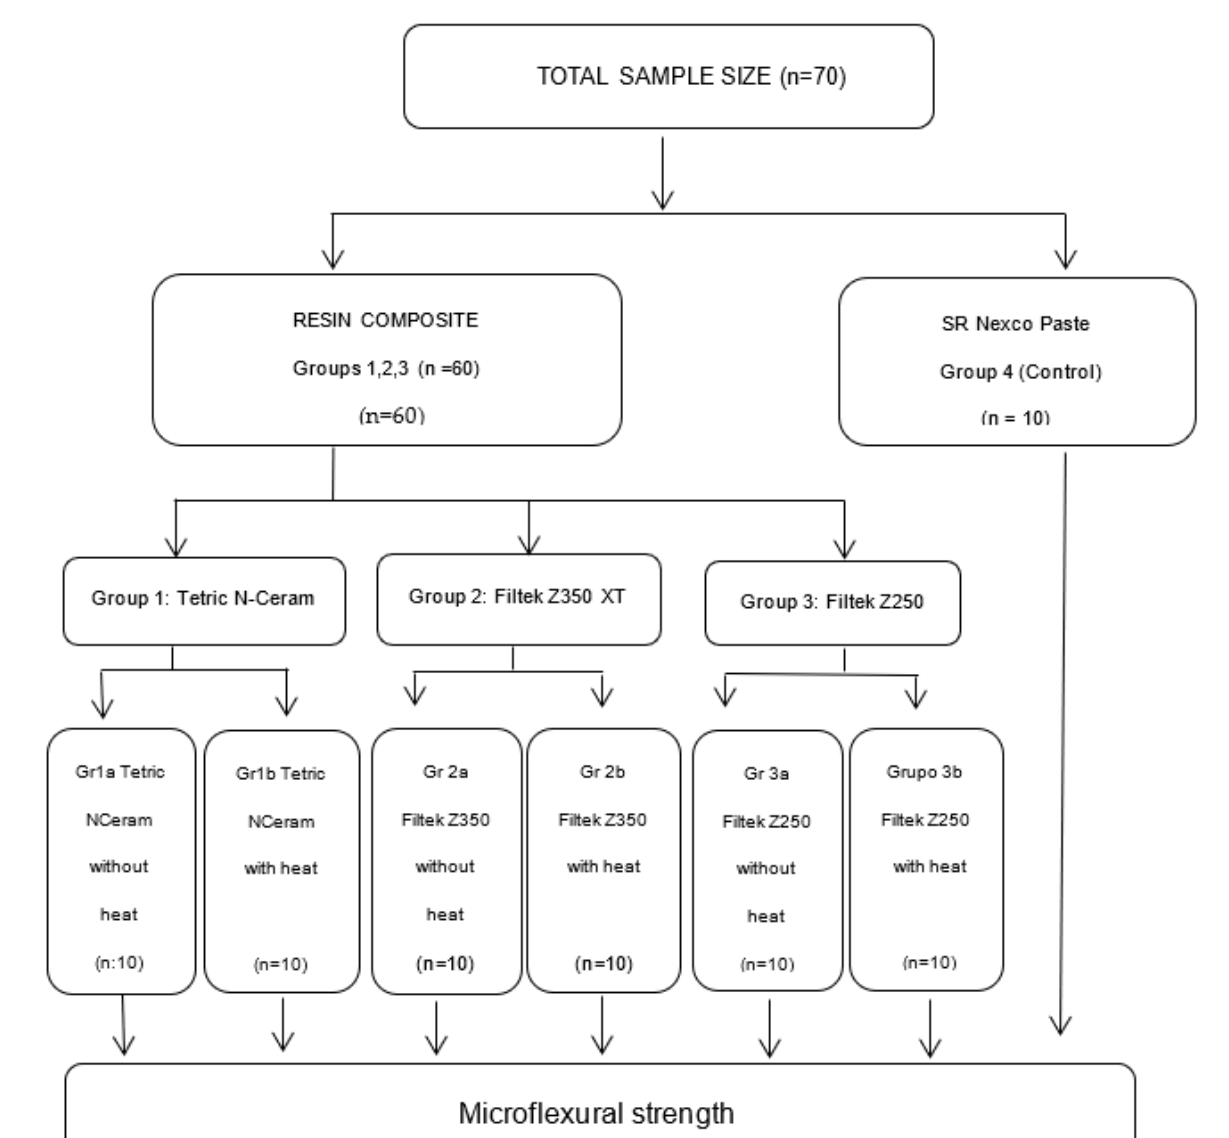
Figure 1. Random distribution of groups according to the sample